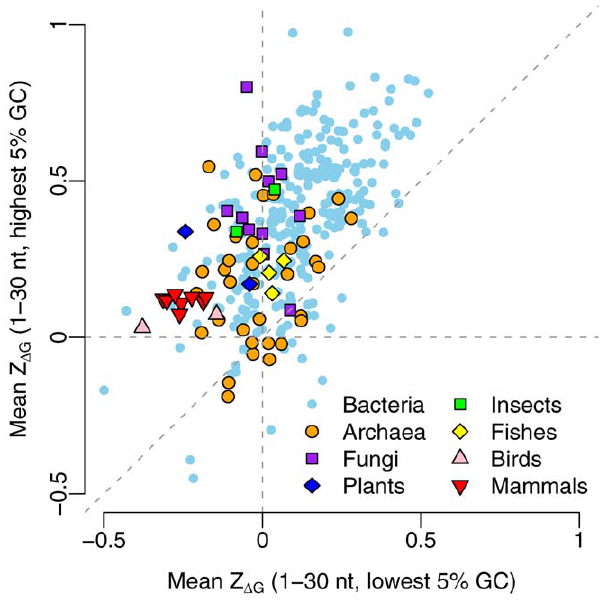
Figure 5. Comparison of the mean 5 9 Z D G between genes with the highest 5% and the lowest 5% GC content within each genome. Each data point represents one organism.